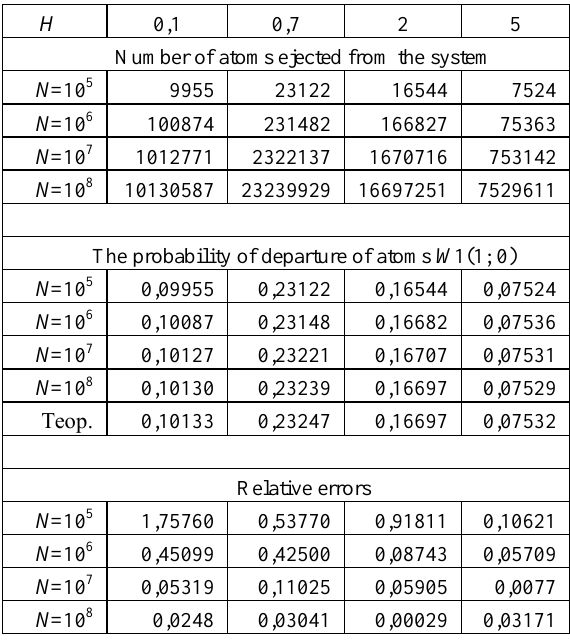
Table 6. Probabilities of atomic departures from slit systems W1(1;